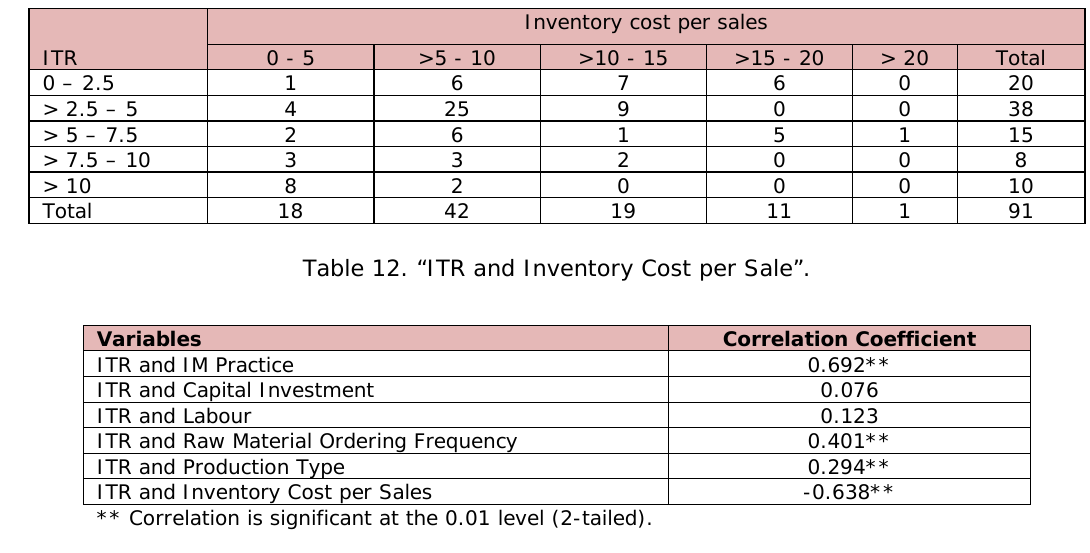
Table 13. “Rank Correlation between ITR and Other